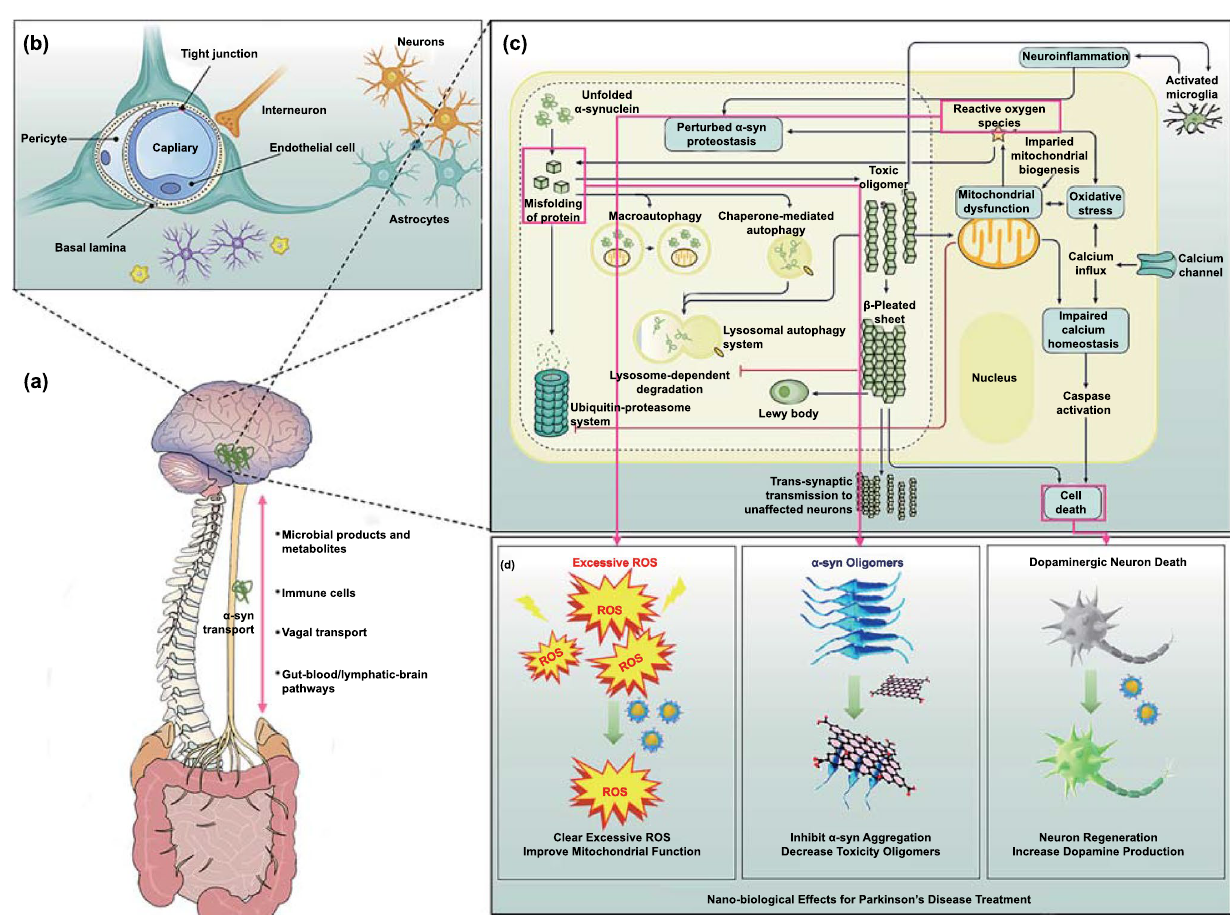
Fig. 1 Pathology of PD and nano-bio effects useful for its treatment. a The gut microbiota–brain axis that promotes the transport of α-syn from the brain to the gut. The brain-gut communication pathways are of four types: (1) microbial products and metabolites that directly enter the brain; (2) the microbiome, which regulates the immune systems and indirectly influences the CNS; (3) signals sent to the CNS through vagal nerve terminals; (4) gut–blood/lymphatic–brain pathways, through which the microbiome or its metabolites can directly enter the brain. Adapted with permission from Ref. [40]. Copyright 2021 Springe Nature. b The physiological structure of the BBB, which stop drug enter the CNS. Adapted with permission from Ref. [45]. Copyright 2019 Elsevier B.V. c Schematic diagram depicting interactions between major molecular pathways that are implicated in the pathogenesis of Parkinson disease. Adapted with permission from Ref. [4]. Copyright 2017 Springe Nature. d Nano-bio effects of clearing excessive ROS, inhibiting α-syn aggregation, and promoting neuron regeneration for PD